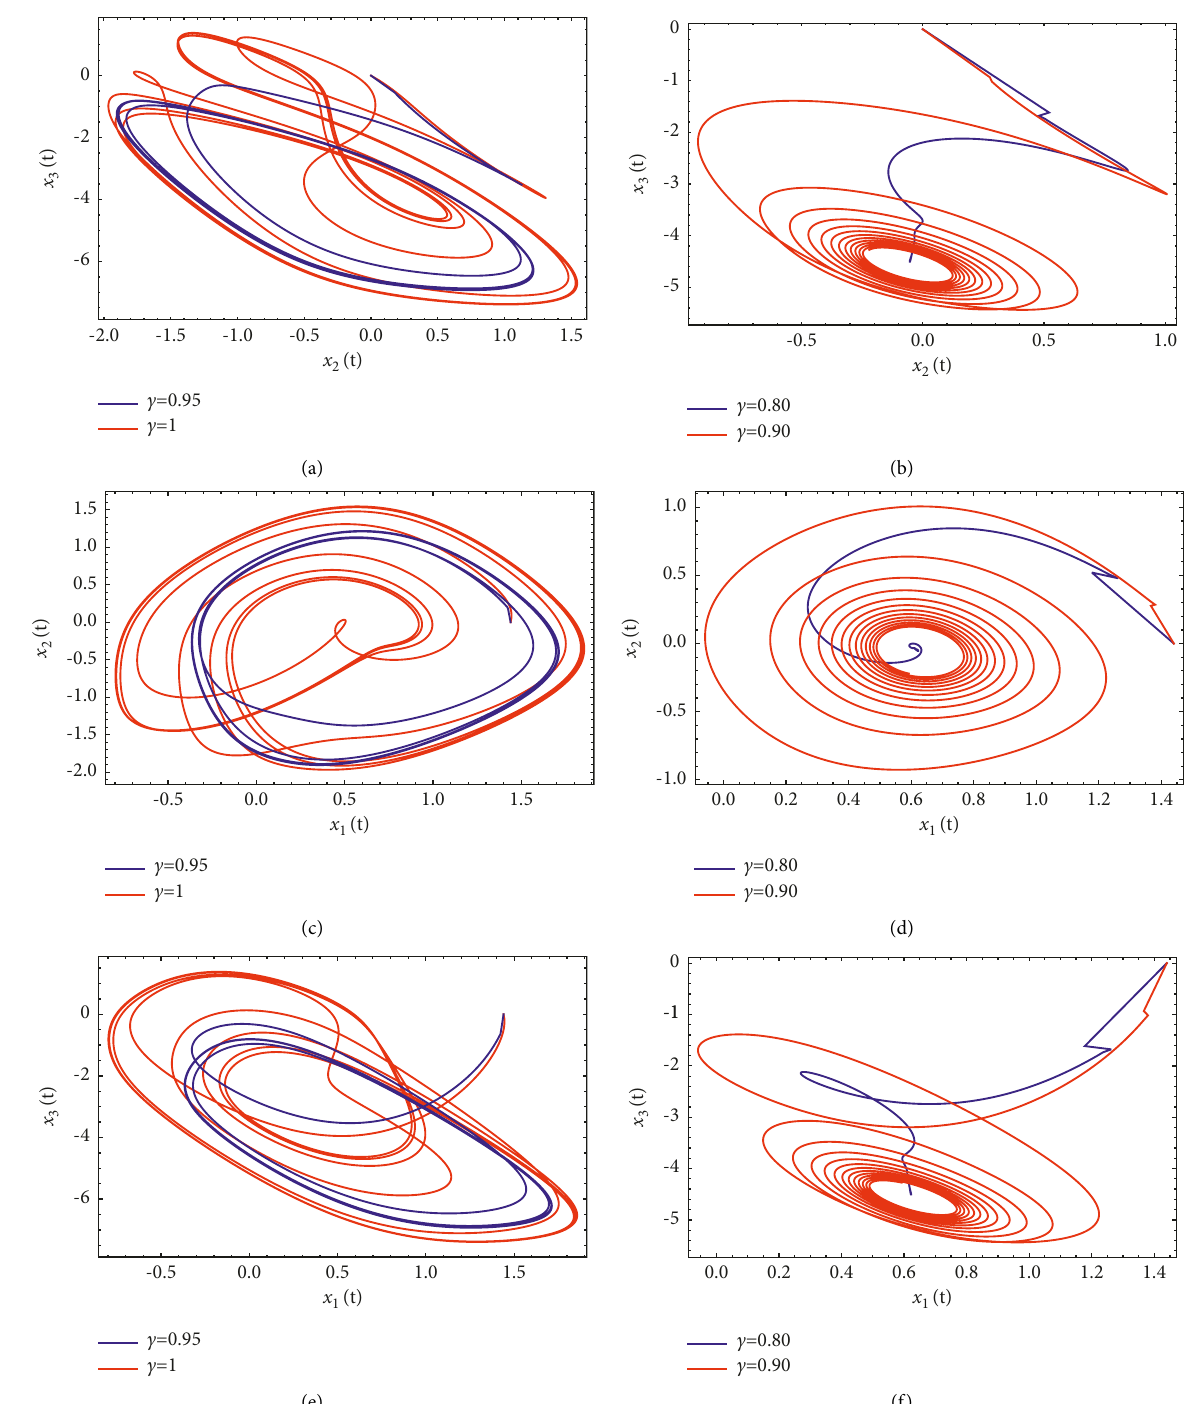
Figure 5: Dynamics of coexisting multiple attractors’ for gradient β orders. (a) State variables x 2 versus x 3 ; (b) state variables x 2 versus x 3 ; (c) state variables x 1 versus x 2 ; (d) state variables x 1 versus x 3 ; (e) state variables x 1 versus x 2 ; (f) state variables x 1 versus x 3